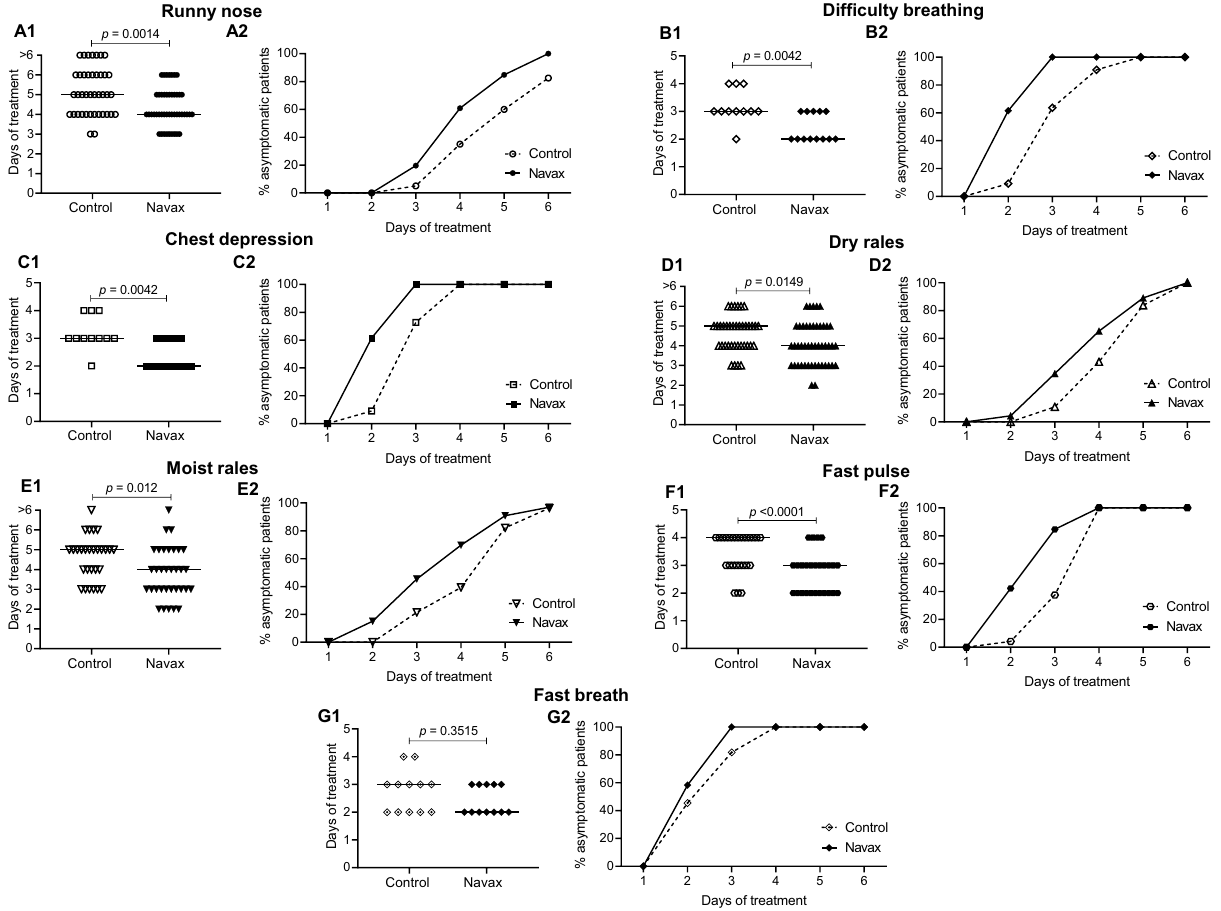
Figure 3. Days of treatment ( A1 – G1 ) and time-dependent percentage (%) of asymptomatics patients ( A2 – G2 ) for observation of seven typical symptoms of ARTIs related to RSV infection in the Control (dashed lines) and Navax (solid lines) groups. More than six days of treatment refers to symptoms that have not improved by day 6. Methods to test distribution was verified by Mann–Whitney